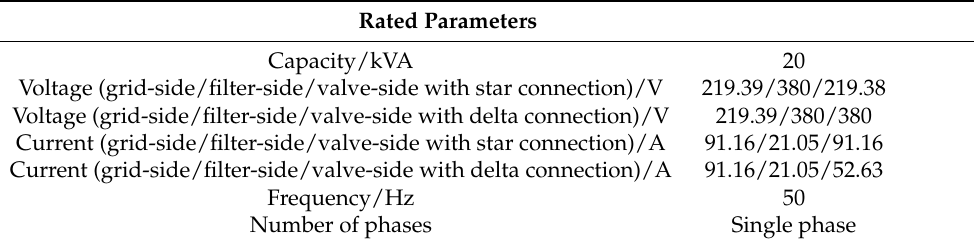
Table 2. Basic parameters of the inductive filter device with a double tuning structure. Filter